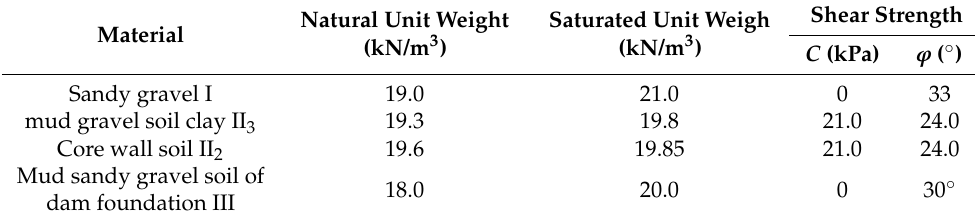
Table 3. Material properties indicators of main